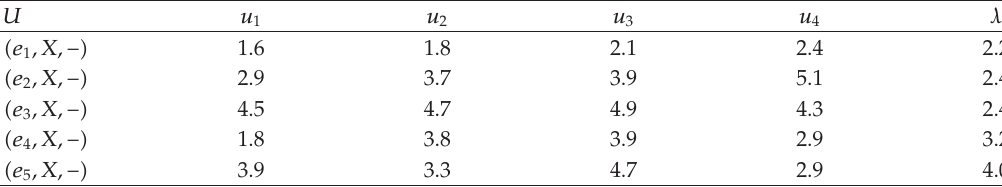
Table 8: Simplified 1-rejected opinions of GFSES.